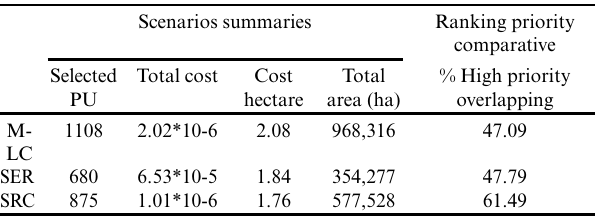
Table 1 . Scenarios, number of planning units (PUs), cost per hectare, and percentage of overlapping with high priority according to the ranking process. MLC = minimal legal compliance scenario; SER = selection by ecological resilience scenario; and SRC = selection by restoration cost